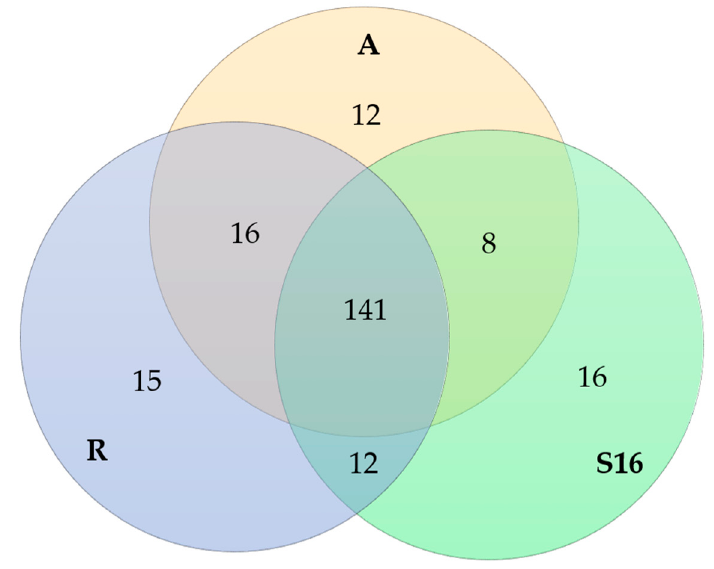
Figure 4. A Venn diagram of the 220 identified metabolites and how they are distributed among the fungal species A ( A. applanata ), R ( P. fortinii ) and S16 ( H. cephalosporioides or C. mutabilis ).